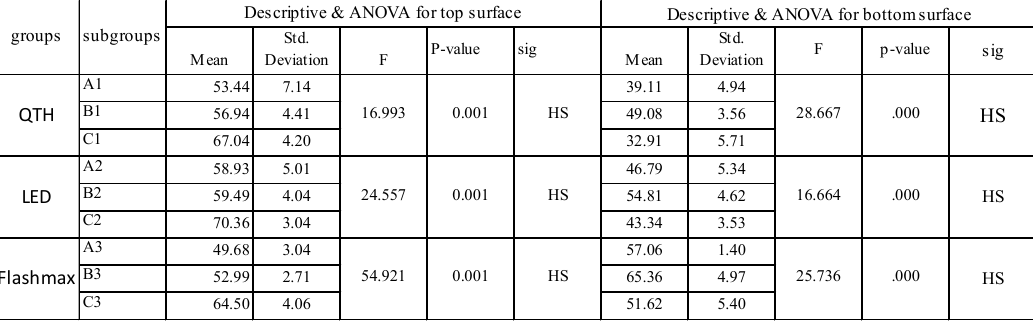
Table 3: Descriptive & ANOVA for the effect of tested light curing systems on top and